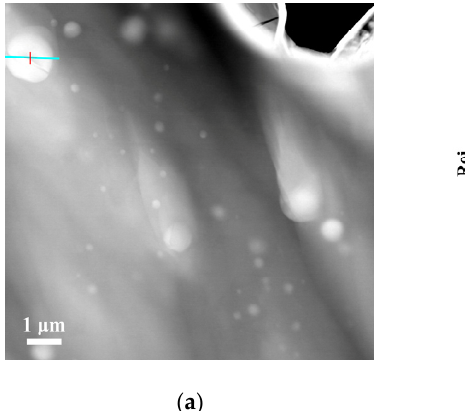
( c ) Figure 6. Distribution of ( a ) Si, ( b ) Y and ( c ) O elements in 1280-S3 ODS steels. 3.2.3. The Structure of Microparticles and Stoichiometric Nanoparticles in ODS Steels